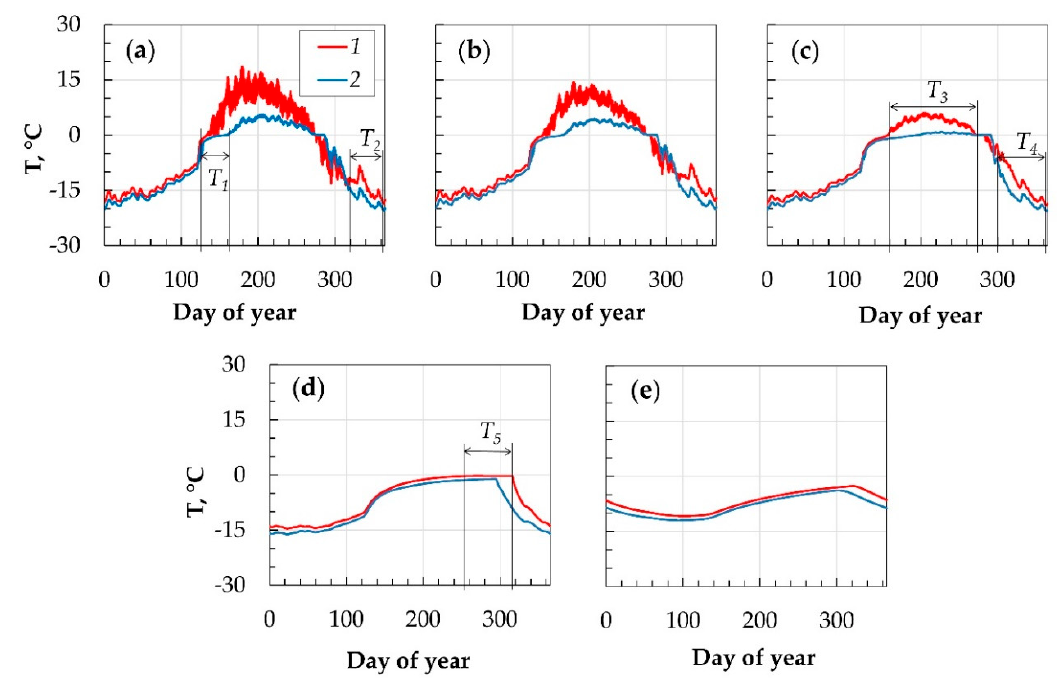
Figure 6. The annual temperature dynamics by depth of the STL: ( a ) 0.05 m; ( b ) 0.10 m; ( c ) 0.20 m; ( d ) 1.00 m; ( e ) 3.00 m in fire-damaged (red curve) and non-disturbed (blue curve) plots. Numeric simulation for the case of non-homogeneous soil water content (NHS) using Pavlov’s (2008) model [45].